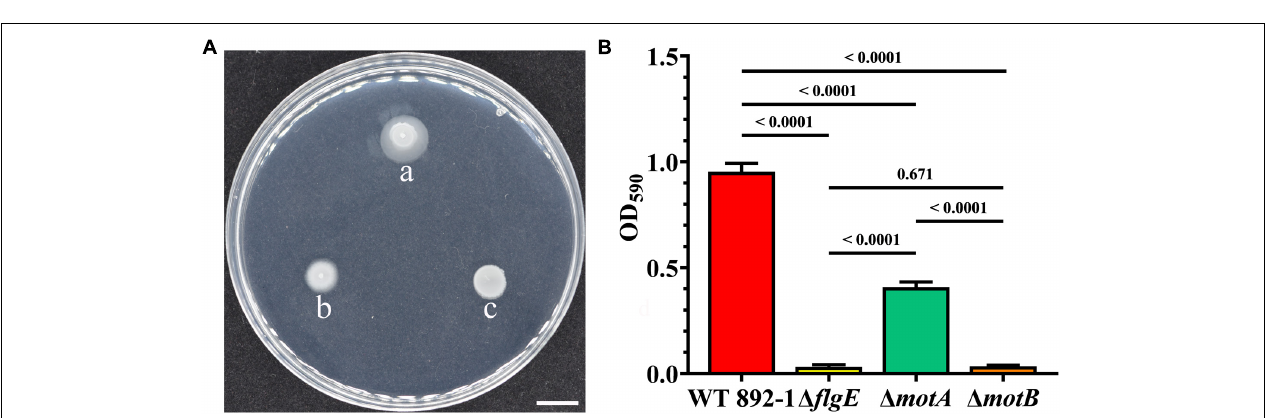
FIGURE 5 | Swimming ability is not necessary for biofilm formation. (A) Swimming motility of wild-type (a), (cid:49) motB (b), and (cid:49) motA (c). Scale bars represent one centimeter. (B) Ring formation by wild-type strain, (cid:49) flgE , (cid:49) motA , and (cid:49) motB . P values were calculated using the Student’s t -test, and used to determine statistical significance between each mutant and the wild-type strain. Error bars represent the standard deviation of the